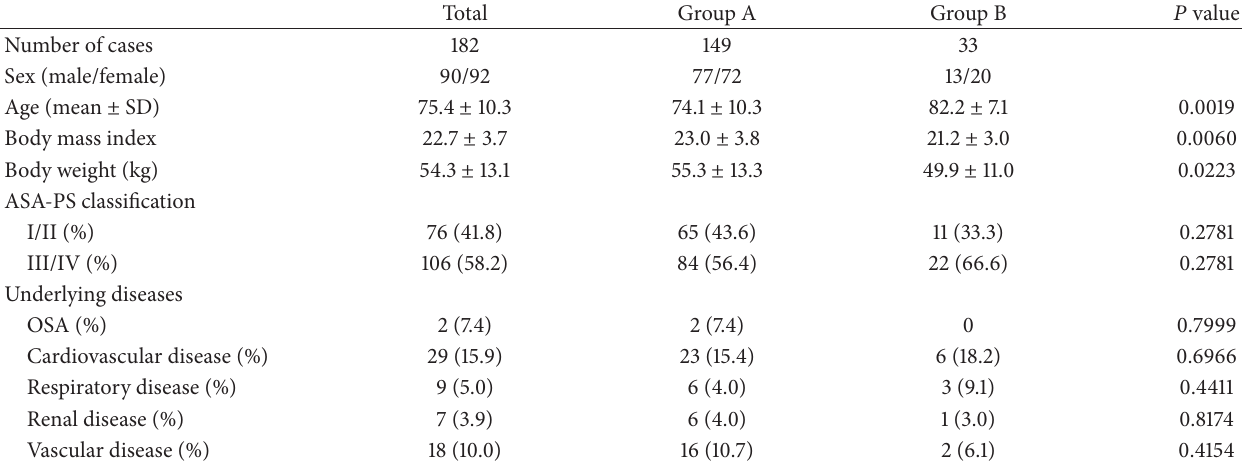
Table 1: Baseline characteristics of 182 patients receiving ERCP with propofol